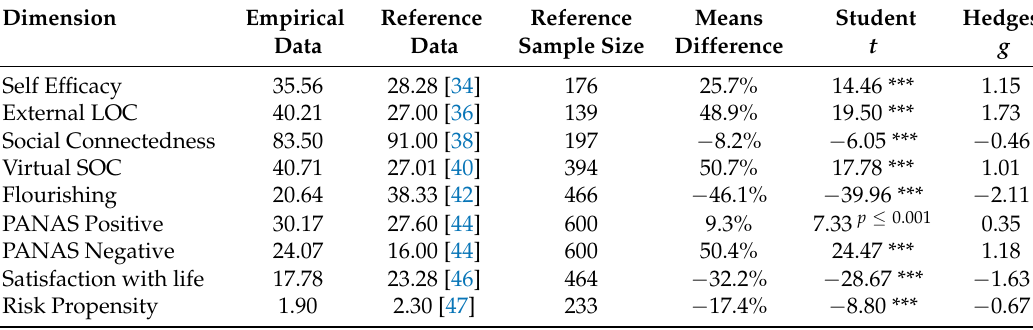
Table 5. COVID-19 impact evaluation: comparisons between respondent results and reference data on the investigated psychological measures. A comparison between the sample’s data and the data from the reference samples. The empirical sample size is always 1556. Dimension Empirical Reference